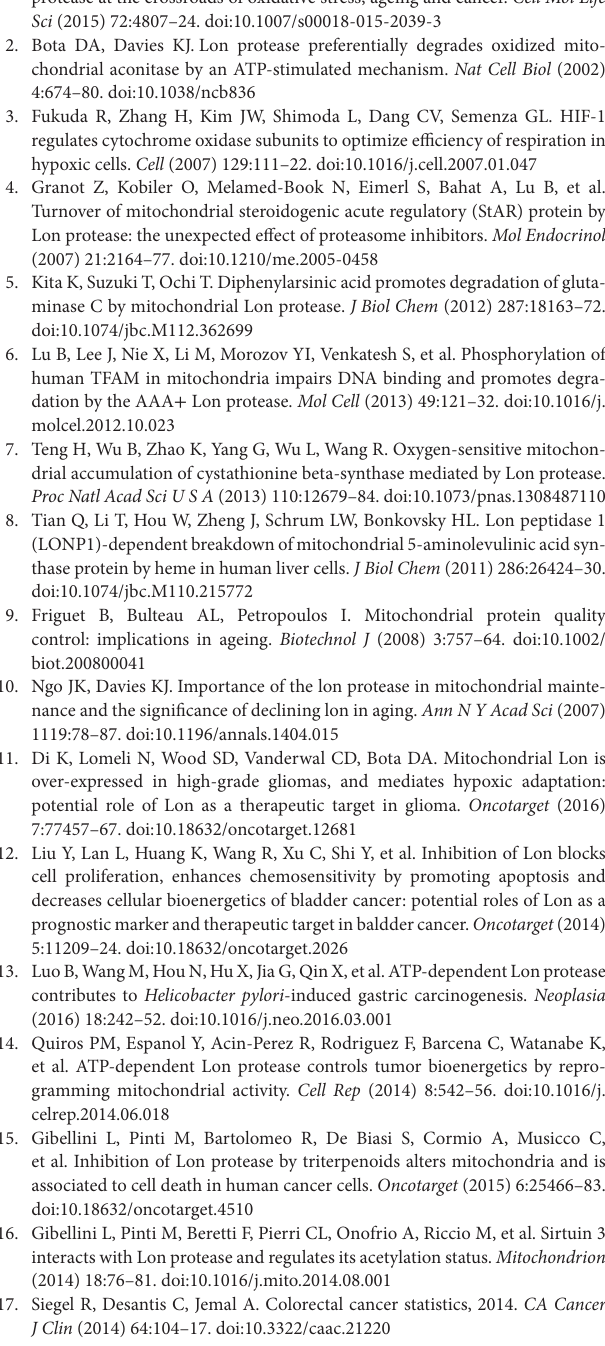
(TMRM) in the presence or absence of CCCP in indicated cells. Data are expressed as percentage of increase in median fluorescence intensity (MFI) and represented the mean ± SD ( n = 3); * P < 0.05. (c) Mitochondrial anion superoxide quantification as assayed by MitoSOX Red Mitochondrial Superoxide Indicator (mitoSOX) in the presence or absence of hydrogen peroxide in indicated cells. Data are expressed as percentage of increase in MFI and represented the mean ± SD (n = 3); * P <